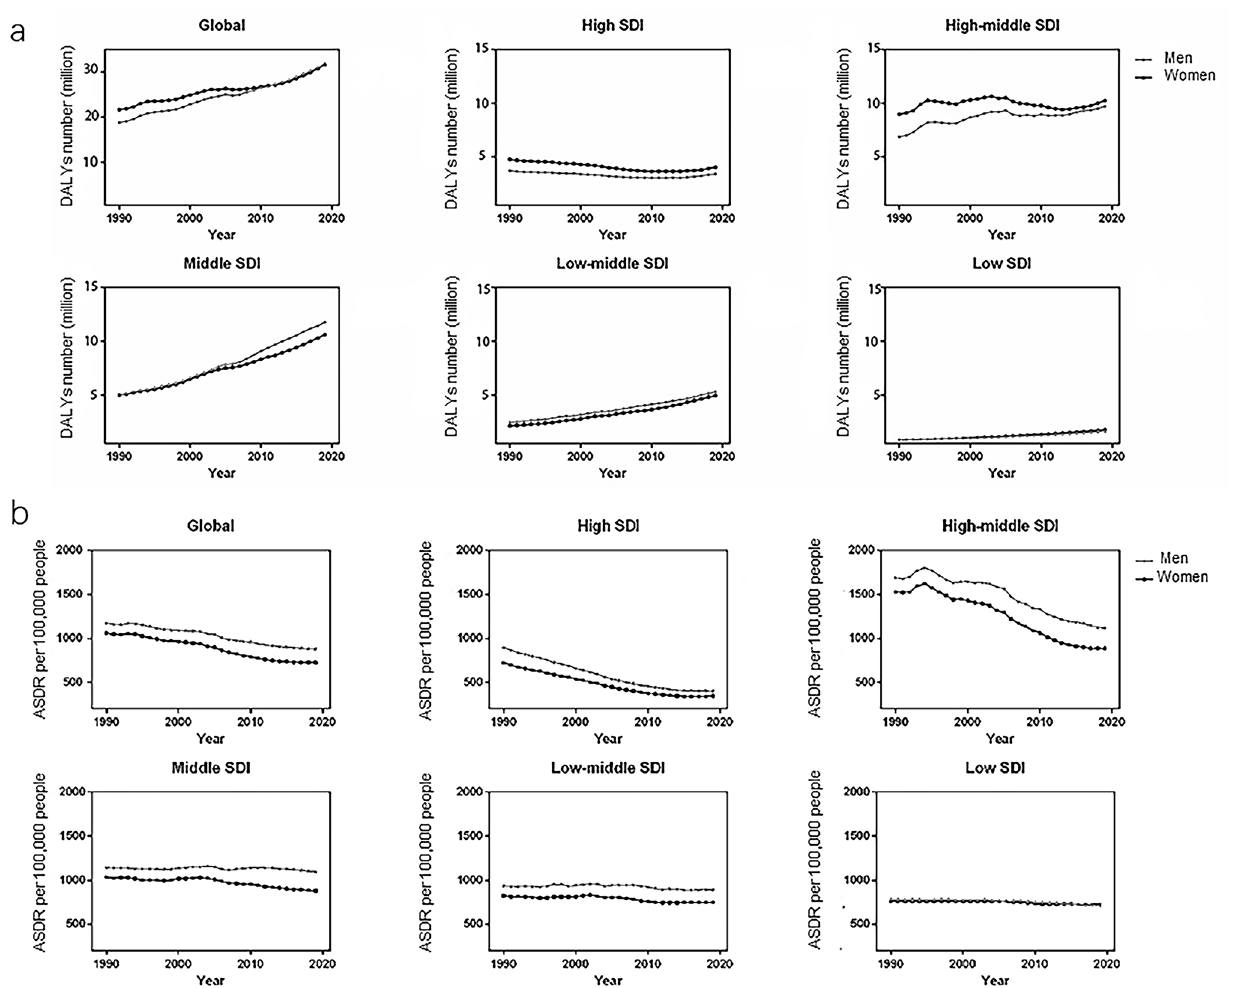
Figure 1. The sex-specific DALYs number ( a ) and ASDR ( b ) due to ischemic stroke in global and five SDI regions from 1990 to 2019. Abbreviations: DALYs, disability-adjusted life years; ASDR, age-standardized DALYs rate; SDI, socio-demographic